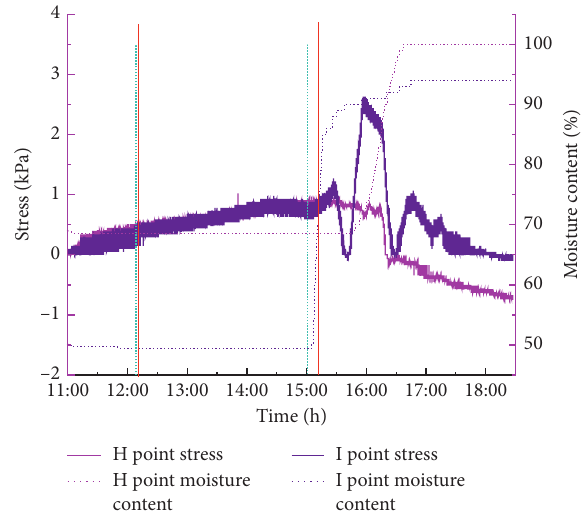
Figure 16: Time history curve of stress-moisture content at H and I measuring points of the vertical section of slope